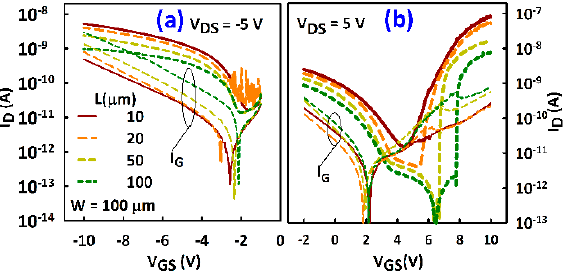
Figure 10. Transfer characteristics (log | I D | vs V GS ) and I G curves for TFTs with a channel width (W) of 100 µ m and varying channel length (L). ( a ) The p-type and ( b ) n-type bias conditions. MAI / PbI 2 = 1.2.